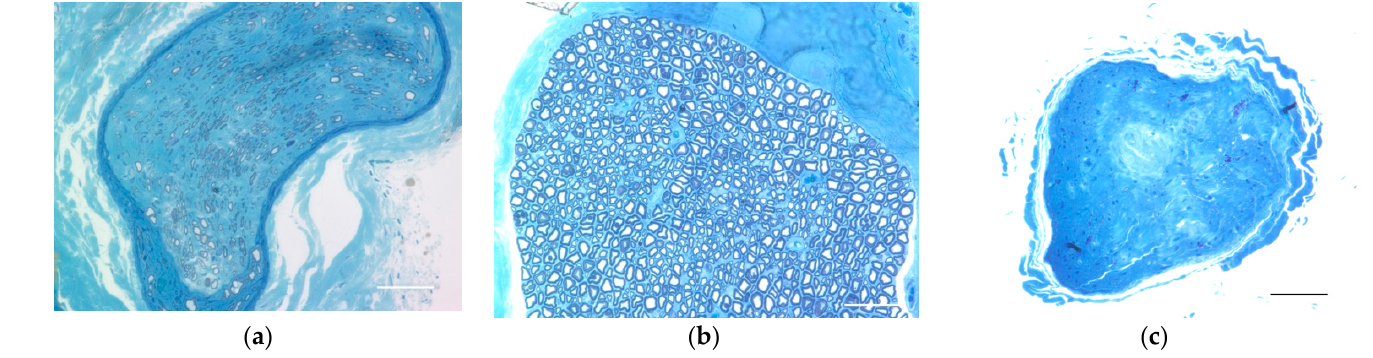
Figure 5. Nerve cross-sections from close to the muscle and distal to the cell transplantation, stained with toluidine blue, show myelinated axons in ( a ) the transplanted nerve and ( b ) the intact nerve, but none in ( c ) the surgical control (without transplantation). Scale bar = 50 μ m.